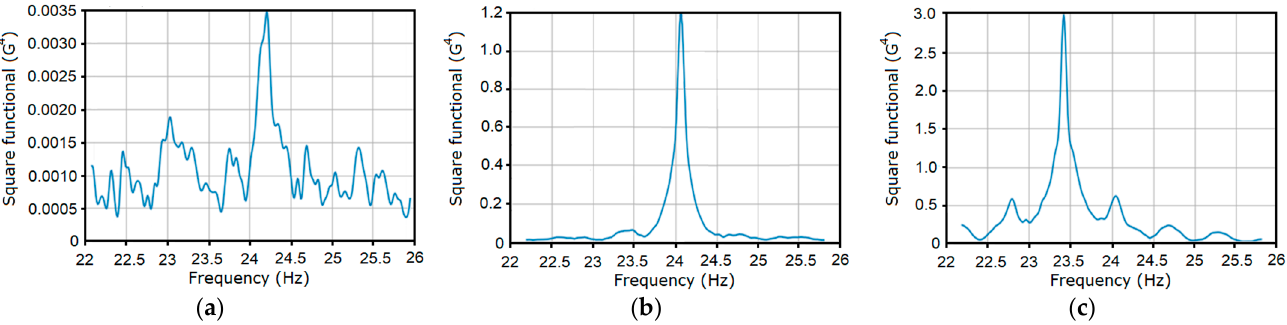
Sensors 2021 , 21 , x FOR PEER REVIEW Figure 11. The estimators of the spectral densities of the vibration of stochastic parts in the high-frequency domain for the first ( a ), the second ( b ) and the third ( c ) stages.